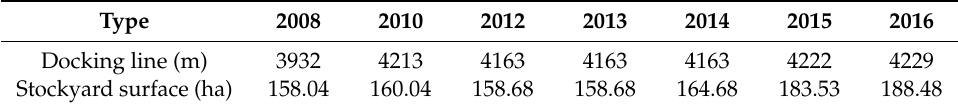
Table 3. Inventory of working machinery and plugs.